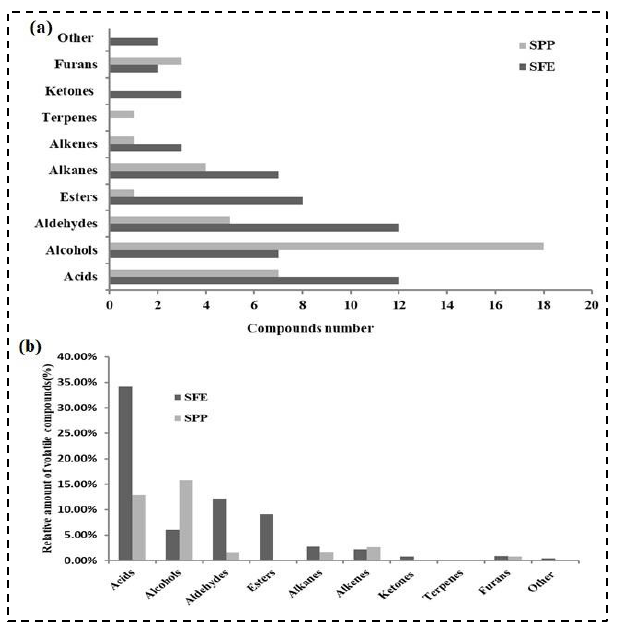
Figure 2. Comparison of volatile components obtained by SPP, SFE and SE of gurum seeds: ( a ) com- pounds number; ( b ) relative amount of volatile compounds